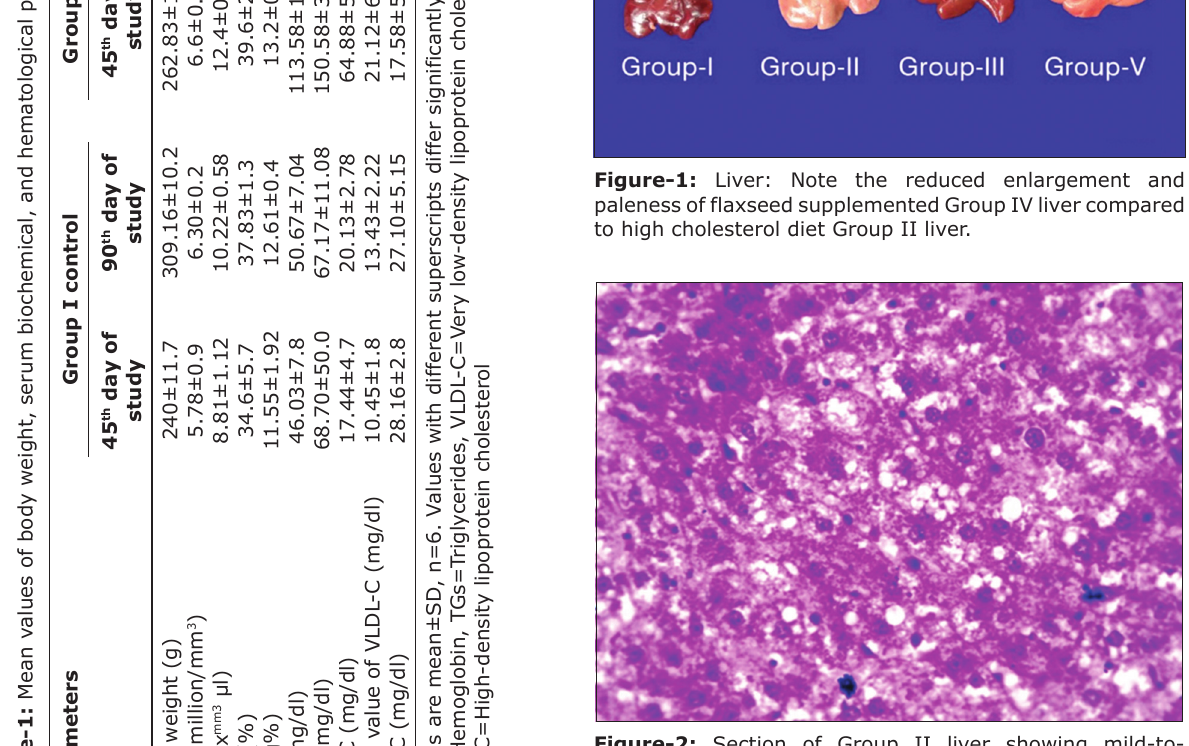
Figure-2: Section of Group II liver showing mild-to- moderate micro- and macro-vascular fat vacuoles in the hepatocytes (H and E,